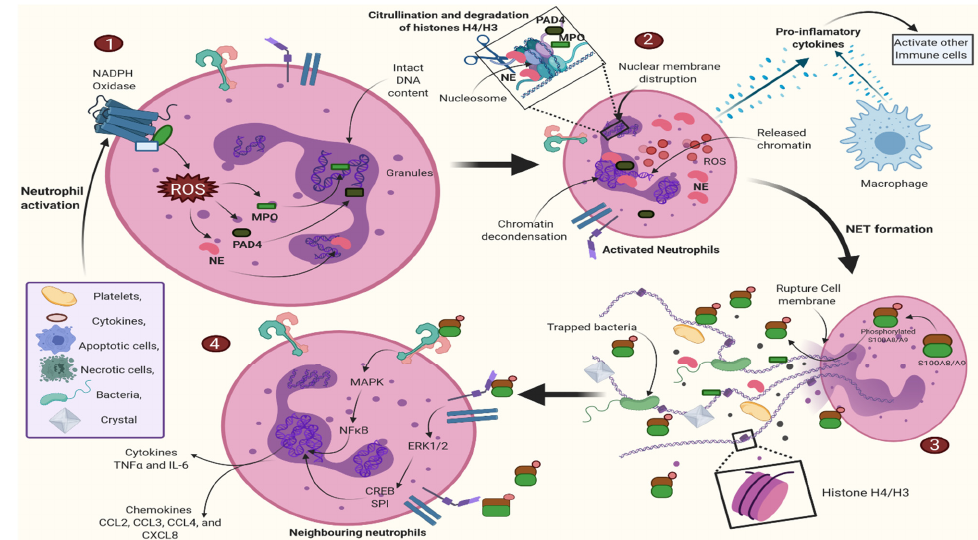
Figure 4. S100A8/PhosphoA9 induces a pro-inflammatory response. Neutrophils stimulated by various stimuli (PMA, MSU, Aspergillus fumigates , or Aspergillus nidulans ) release NETs via a pathway involving NADPH oxidase, PAD4, NE, and MPO. During NET formation, the phosphorylated S100A8/A9 heterodimer is released into the extracellular space. S100A8/PhosphoA9 can then acti- vate neutrophils in the surrounding area, causing them to release cytokines (TNF- α and IL-6) and chemokines (CCL2, CCL3, CCL4, and CXCL8). TLR4 signaling pathways are primarily responsible for this release, while additional receptors (such as RAGE) are involved in S100A8/PhosphoA9-me- diated CCL2 secretion. As a result, S100A8/PhosphoA9 produced by neutrophils is implicated in amplifying the inflammatory process, and may be a defining feature of inflammatory disorders. Here, MPO stands for myeloperoxidase; MSU stands for monosodium urate monohydrate; NE stands for neutrophil elastase; PAD4 stands for peptidyl arginine deiminase; PMA stands for phor- bol 12-myristoyl 13-acetate; NET stands for a neutrophil extracellular trap; NADPH oxidase stands for nicotinamide adenine dinucleotide [35]. Created with BioRender.com. Activated neutrophils induce chromatin decondensation, nuclear membrane disrup- tion, and chromatin release during NETosis [36,37] (Figure 4). NETs (neutrophil extracel- lular traps) capture microbial invaders, such as fungi and bacterial pathogens, and may have evolved to trap critical microbes that are difficult to consume by phagocytosis. The process is primarily characterized by the release of chromatin, which consists of extended chromatin fibers that intersect and bundle with one another, forming a mesh-work or trap that immobilizes extracellular microorganisms, and is thus referred to as a NET [35]. In vitro induction of NETs has recently demonstrated functional involvement of the S100 protein group. Neutrophil activation is triggered by stimuli such as Aspergillus fumigates or Aspergillus nidulans , PMA, or MSU, and releases NETs through a mechanism involving NADPH oxidase, myeloperoxidase (MPO), NE, and PAD4. During this step, phosphory- lated S100A8/A9 heterodimers are secreted into the extracellular space by neutrophils. Consequently, S100A8/phospho-S100A9 establishes the surrounding neutrophils by ener- gizing them for TNF- α and IL-6 (cytokines) secretion and CCL2, CCL3, CCL4, and CXCL8 (chemokines). The secretion of these chemokines and cytokines is primarily regulated by the TLR-4 and RAGE receptors (participate in CCL2 secretion) over the surface, locally or nearby accessible neutrophils at the inflammatory site. This mechanism indicates that the S100A8/A9 heterodimer plays a significant role in the progression of the inflammatory process [35].